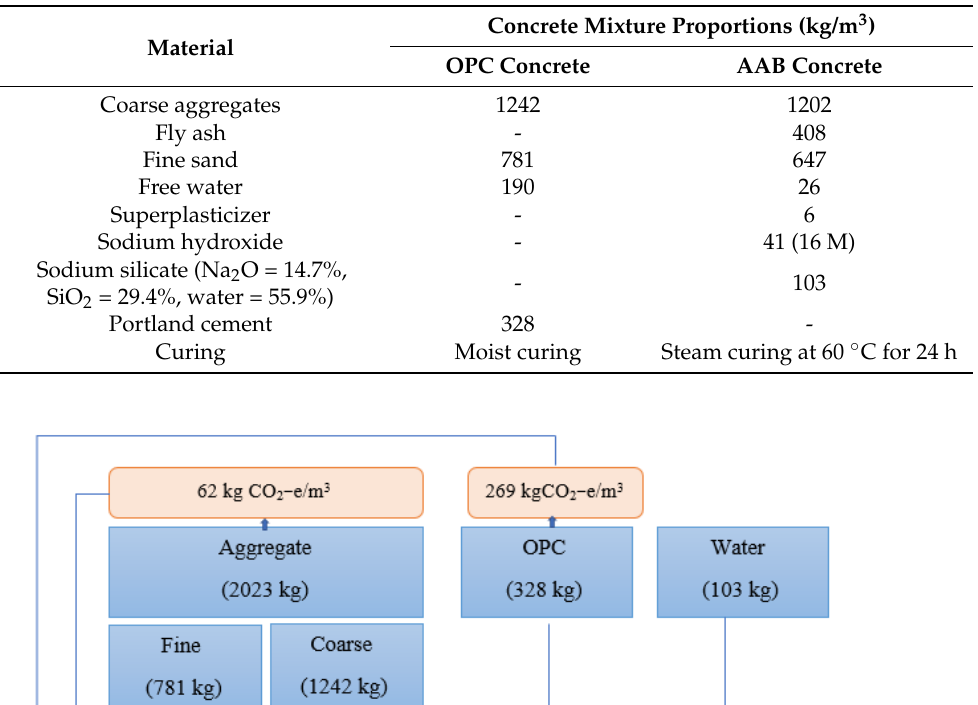
Table 1. Mixture proportions for 40 MPa concrete [12].